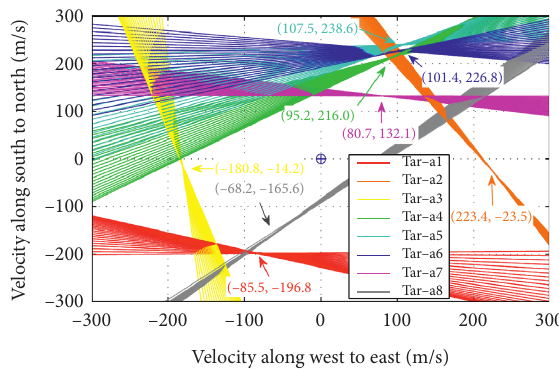
Figure 14: Constant velocity equation map with ADS-B information.